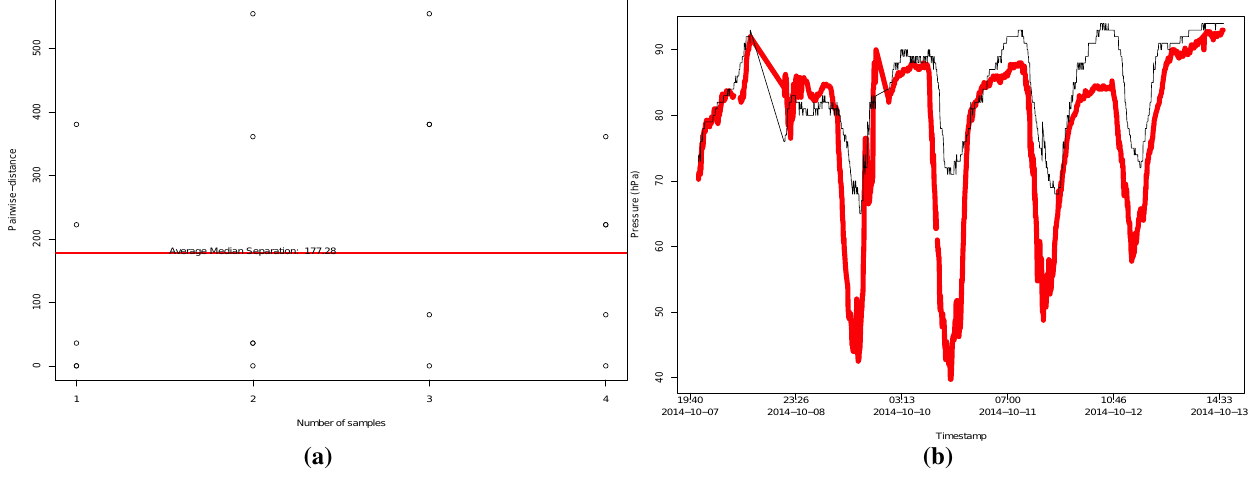
Figure 14. Analysis of humidity data from sensors in a range of 100 km from the coordinates of London, UK, in Dataset 2, considering a limit of r ≥ 0 . 65 . ( a ) Pairwise-distances for humidity sensors; ( b ) Estimation of the humidity, resulting in a MSE = 104 . 213 .